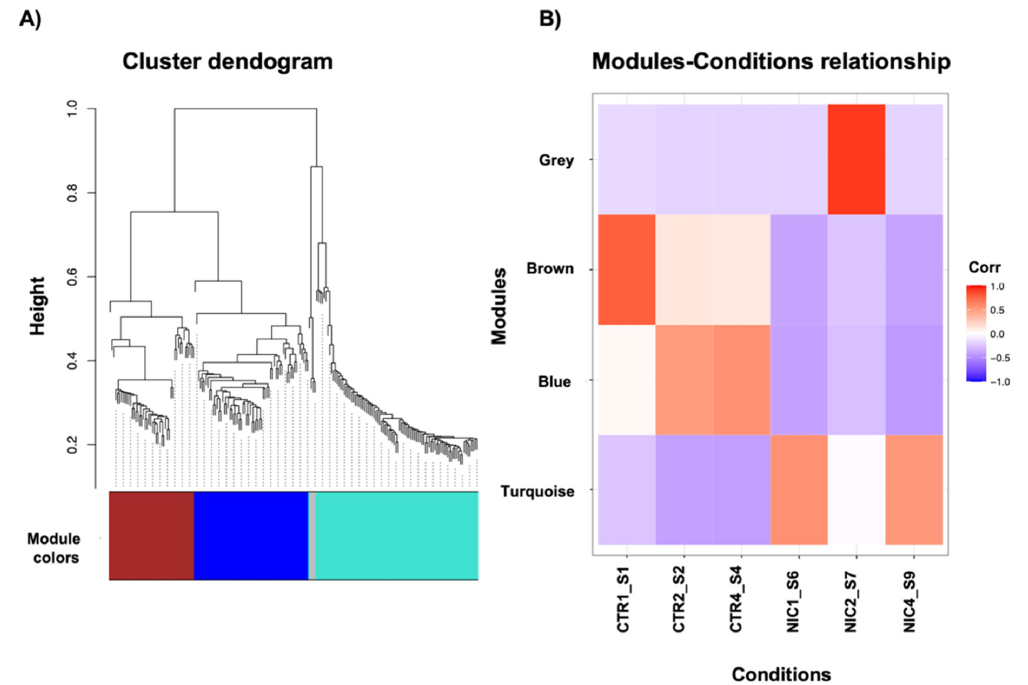
Figure 2. Weighted co-expression analysis network between the top 100 most deregulated coding and non-coding genes in terms of |log2FC|. ( A ) Clustering dendrograms of genes, with dissimilarity based on topological overlap, together with assigned module colors. As a result, 3 co-expression modules were constructed and were shown in different colors. The turquoise module was the largest one with 89 genes, followed by the blue with 62 genes and the brown with 46 genes. ( B ) Heatmap showing correlation between gene modules and conditions (e.g., Nichoid-growth NPCs and standard floating conditions). Different colors are related to different correlation values. For further analysis we focused our attention on turquoise and blue